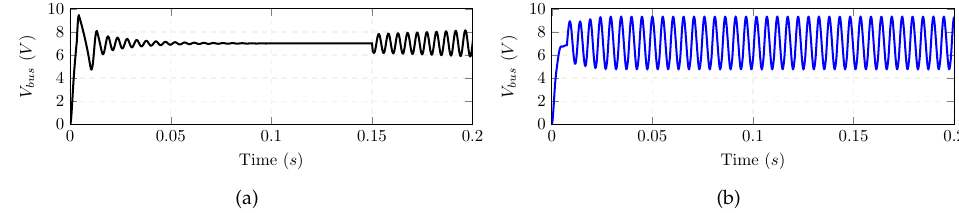
Figure 12. The instability of the system with the conventional controller: ( a ) sequential loading; and ( b ) full loading.